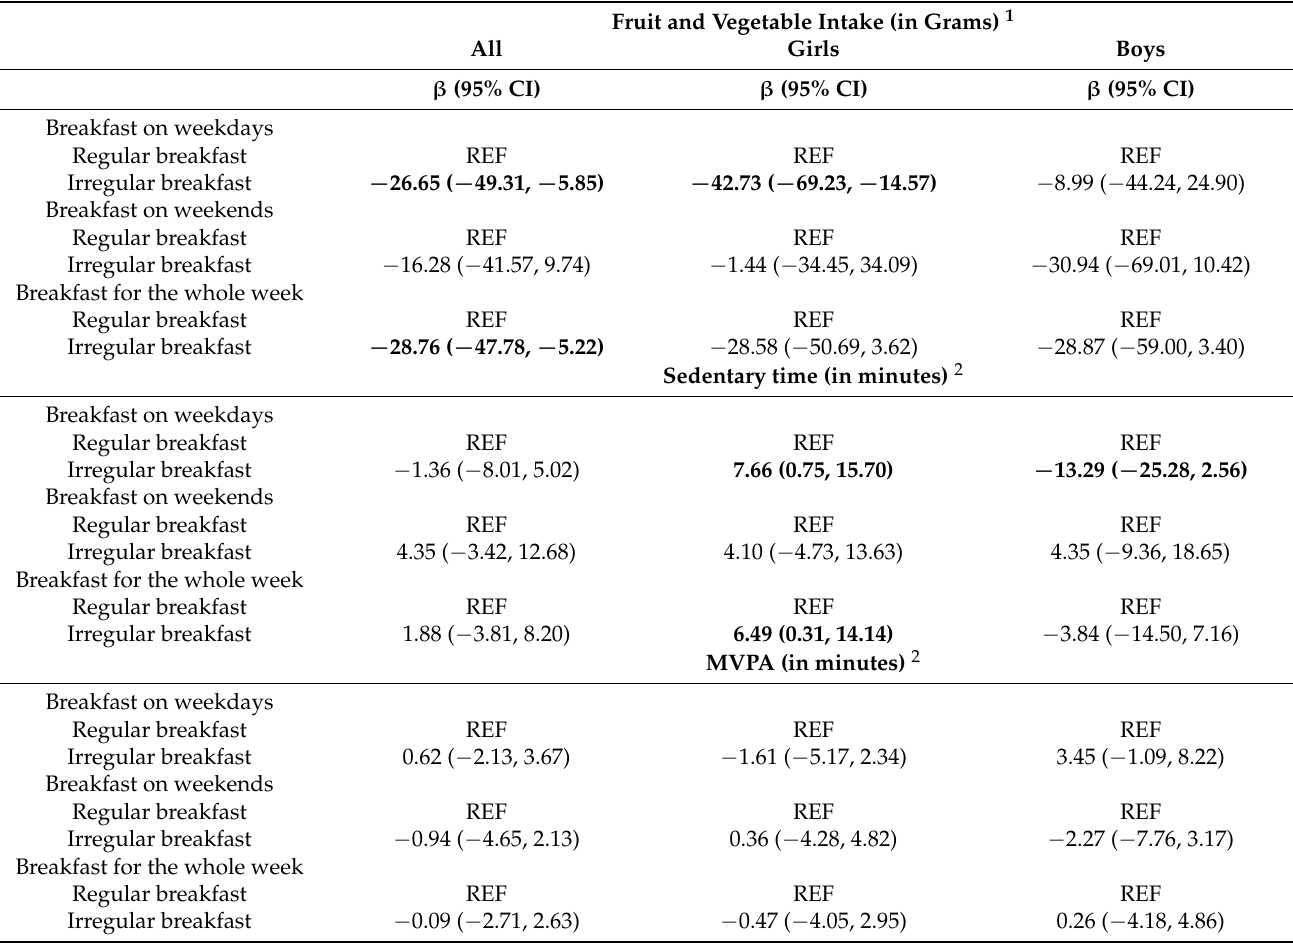
Table 2. Associations between breakfast (exposure), fruit and vegetable intake, sedentary time, and moderate-to-vigorous physical activity (outcomes).